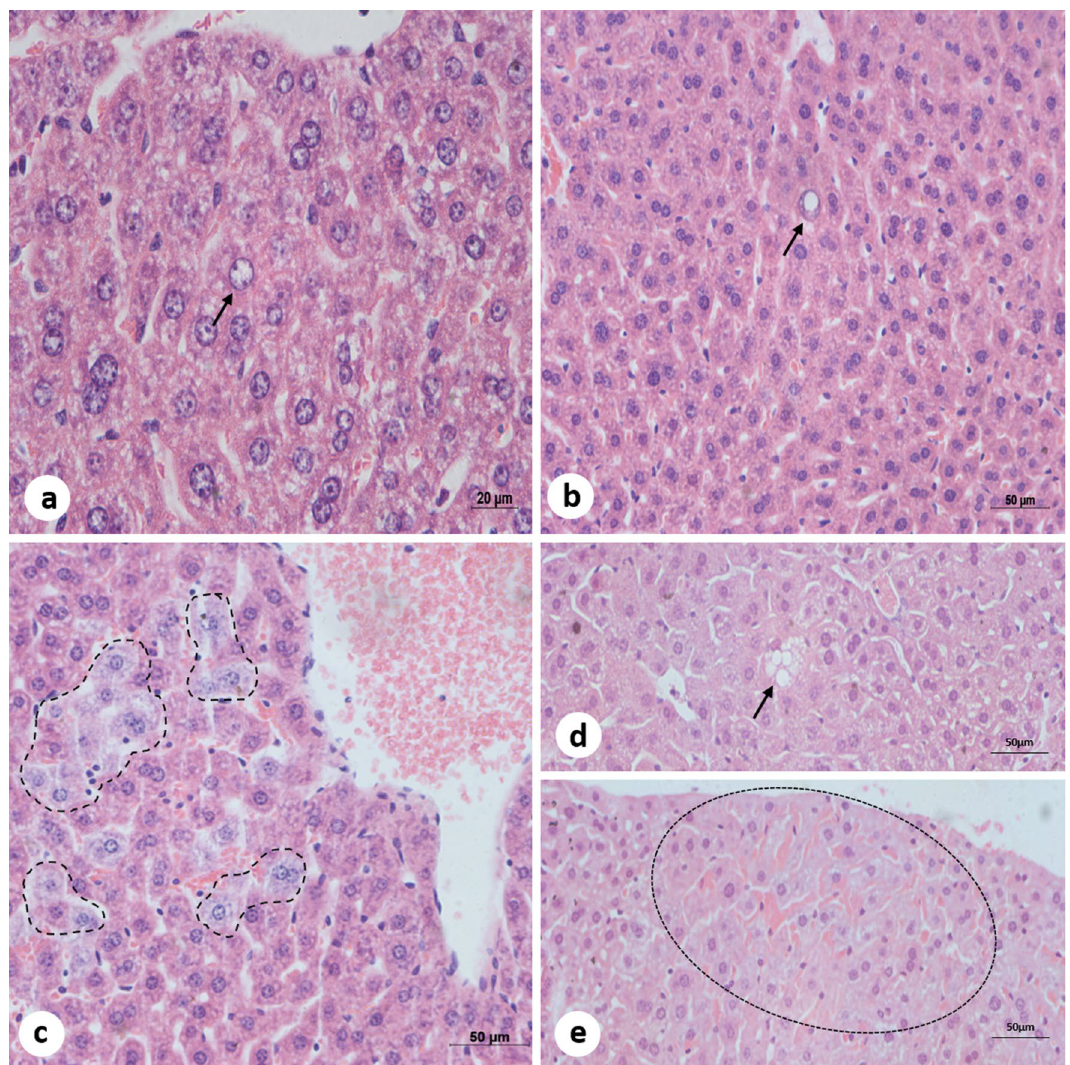
Figure 7. Liver micrographs of BALB/c mice infected with DENV-2 Lineage I (Lin I) or II (Lin II). H&E staining. ( a ) (Lin I), ( b ) (LinII) nuclear atypias (arrows). ( c ) (Lin II) signs of necrosis (dashed outline). ( d ) (Lin